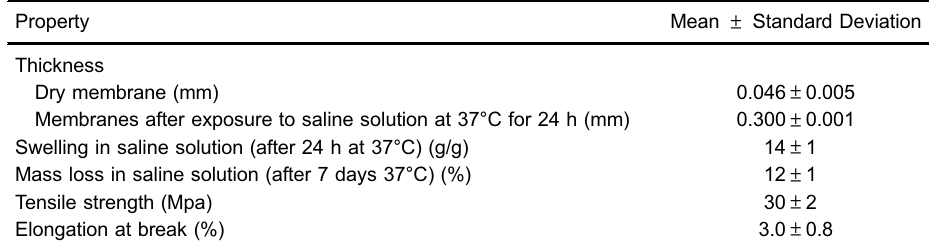
Table 1. Physicochemical characteristics of the chitosan-alginate membranes.